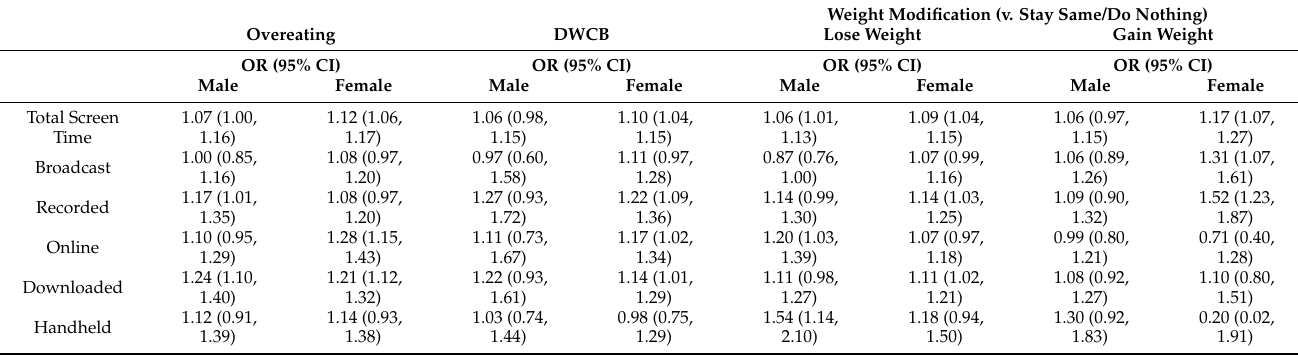
Table 3. Sex-stratified associations * of television viewing time and different screen viewing modes with overeating, disordered weight control behaviors (DWCB), and weight modification. Weight Modification (v. Stay Same/Do Nothing) Overeating DWCB Lose Weight Gain